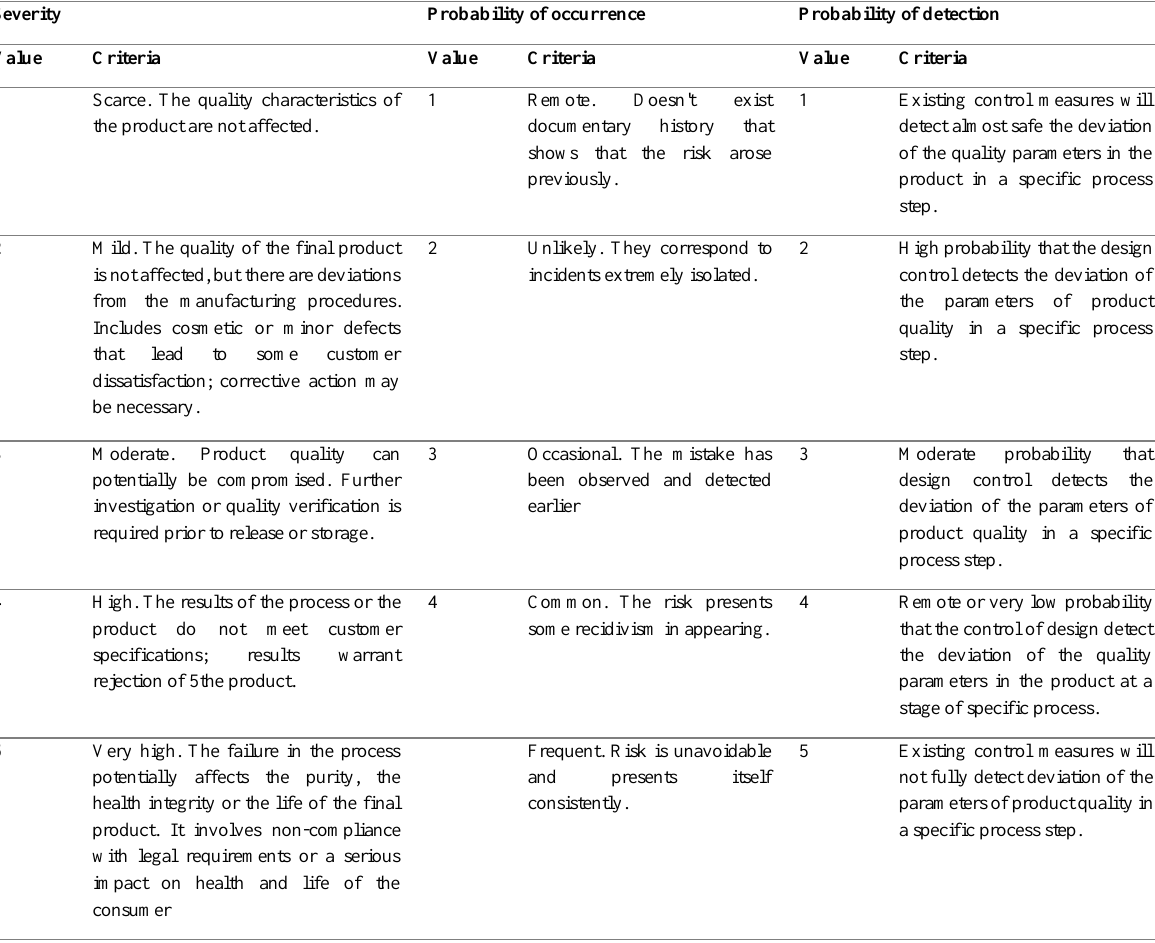
Table 2 : Parameters and values used in risk